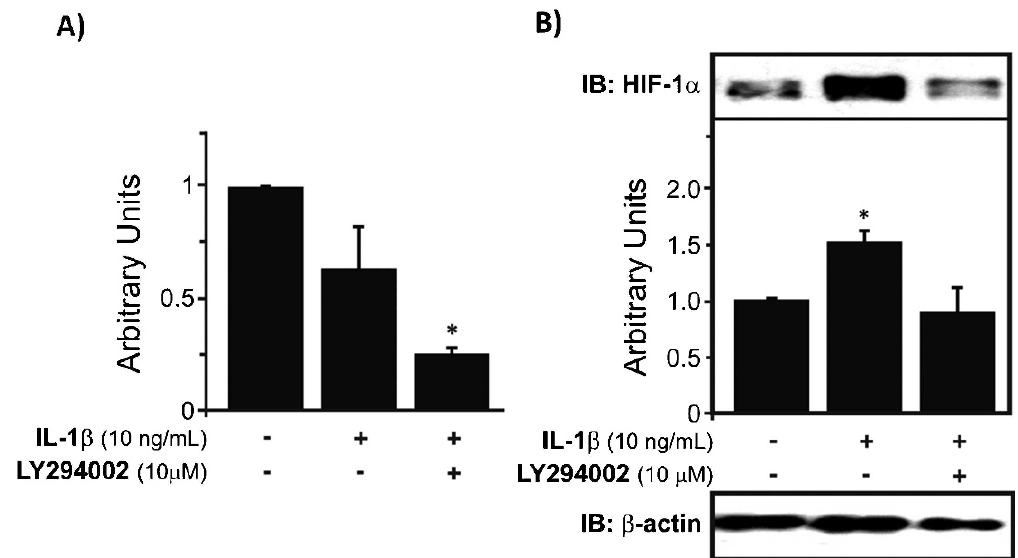
Figure 1 - HIF-1 a mRNA expression and protein levels in human chondrocytes treated with IL-1 b . A) IL-1 b decreases HIF-1 a mRNA expression in human chondrocytes cultured under normal oxygen conditions, and the combination of IL-1 b and LY294002 downregulated HIF-1 a mRNA even further (* p , 0.05). B) Upregulation of HIF-1 a protein levels was observed under treatment with IL-1 b (* p , 0.05), which was largely abolished by LY294002 treatment, suggesting that this upregulation occurs, at least in part, through the PI-3K pathway. This graph depicts the results normalized to endogenous b -actin protein